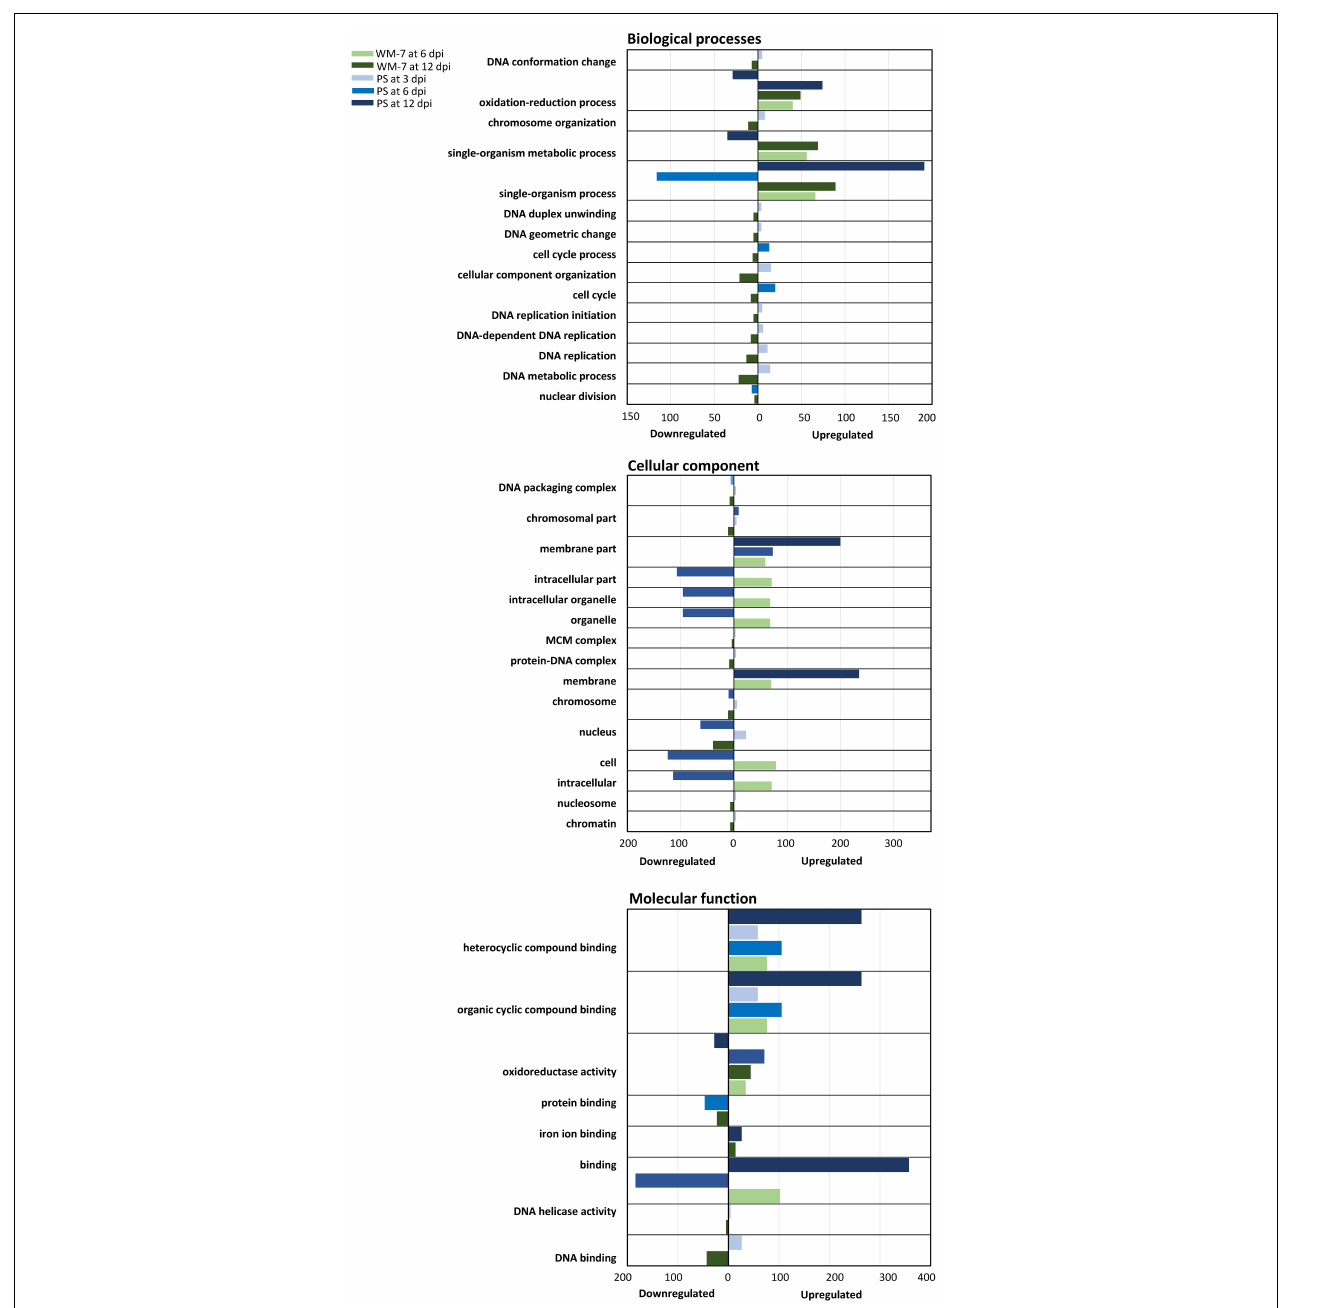
FIGURE 5 | Gene ontology (GO) classification. The number of upregulated or downregulated genes assigned to each class were calculated at 3, 6, and 12 dpi to WM-7 and PS and represented in colors according with the legend.